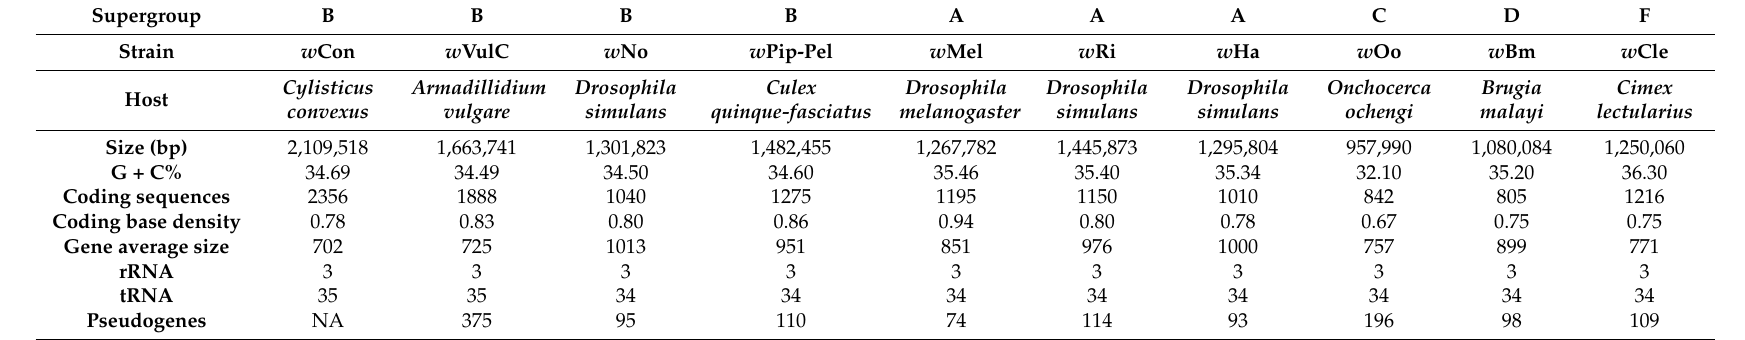
Table 1. Wolbachia genome features with w Con and w